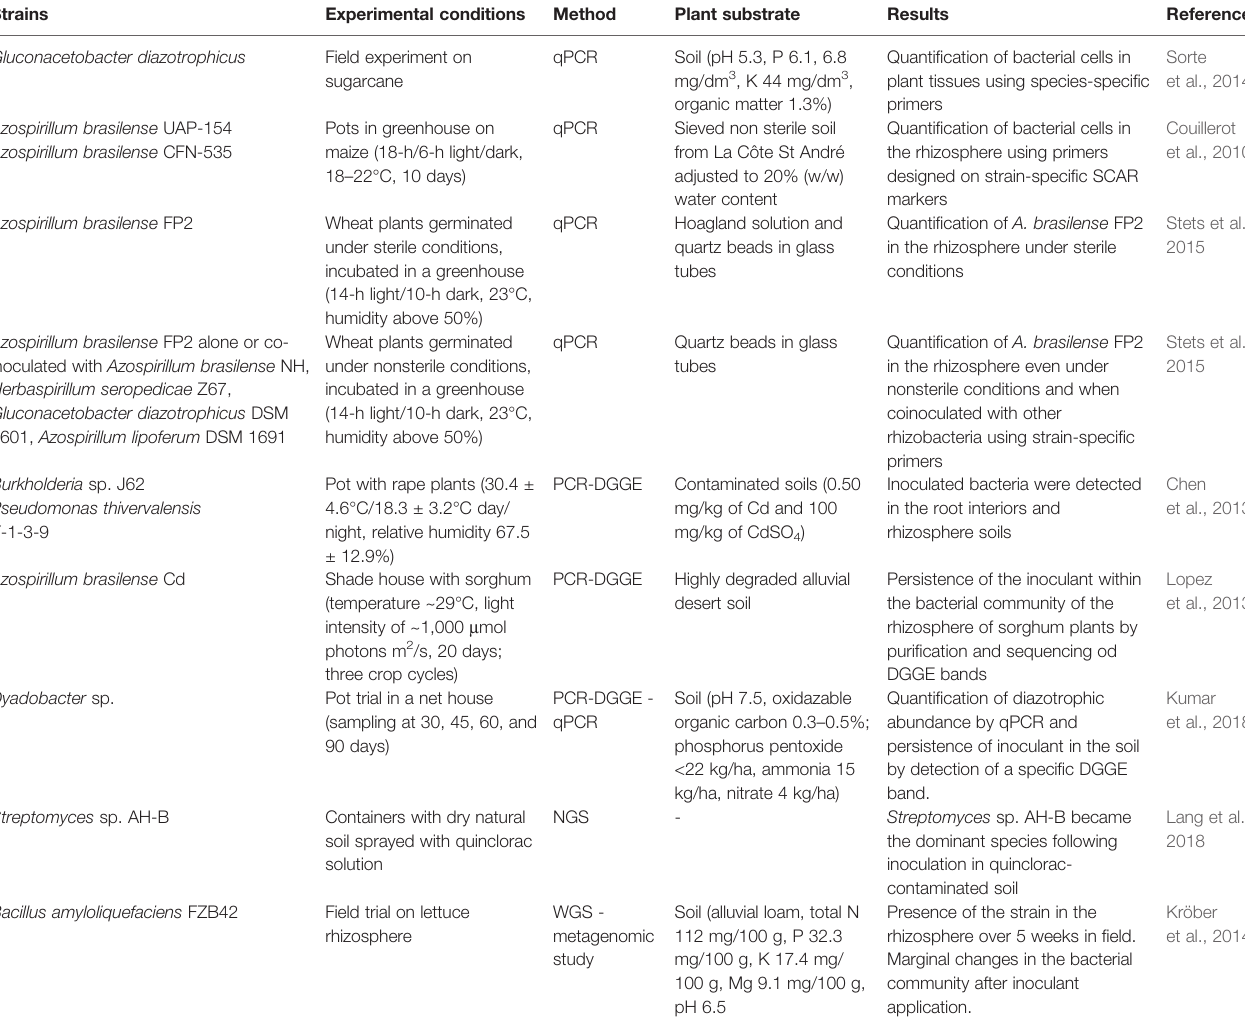
TABLE 3 | Molecular approaches used to monitor plant growth ‒ promoting bacteria and root interaction.